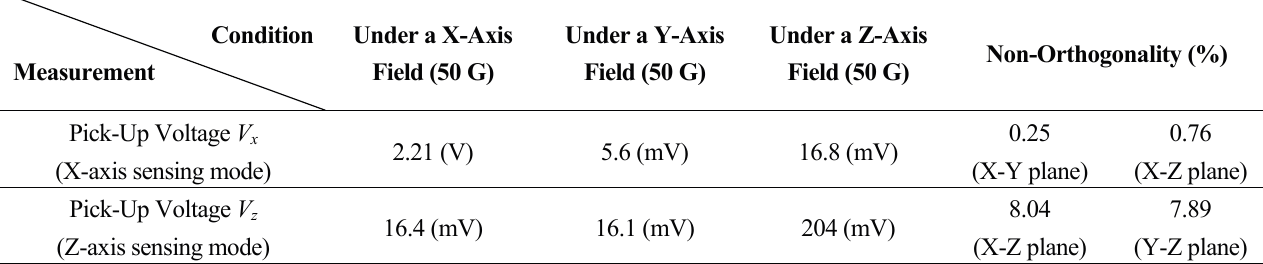
Figure 3. Flux line diagrams illustrate the sensing principle of the planar fluxgate with a cruciform core and an orthogonal fluxguide, and the cross-section is along the longitudinal core: ( a ) in X-axis sensing direction; ( b ) in Z-axis sensing direction. Table 1. The experimental results of orthogonality